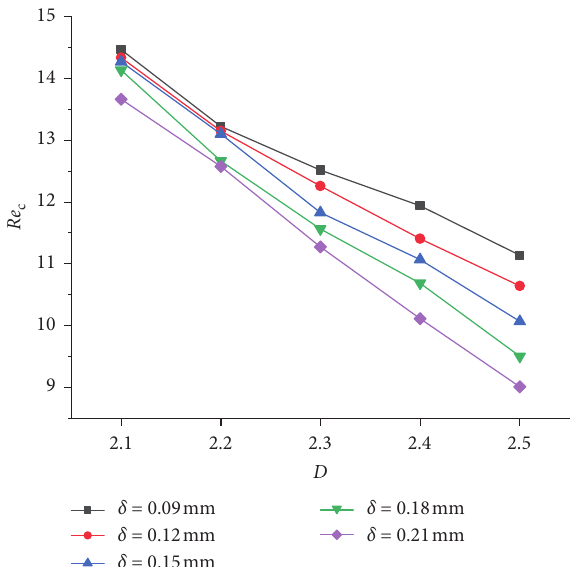
Figure 9: Relationship between the critical Reynolds number and geometric